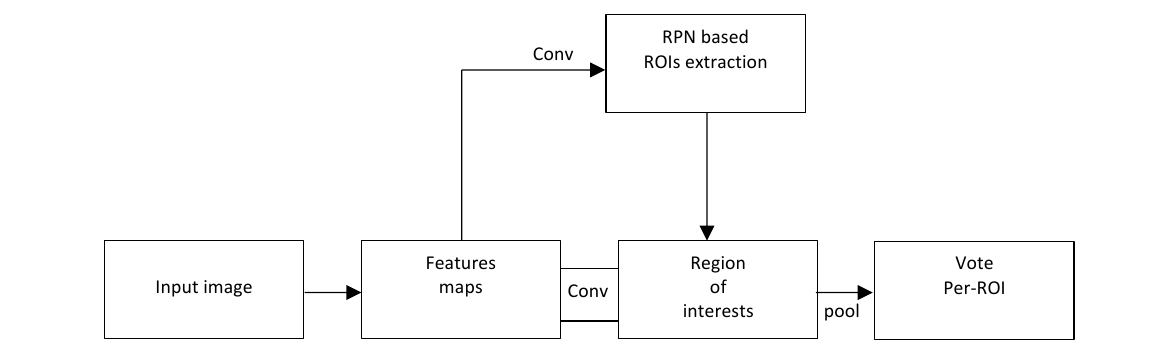
Figure 6. Region-based fully convolutional network model (Adapted from ref. [4]). SSD: Liu et al. [15] proposed a single-shot detector (SSD) designed for real-time